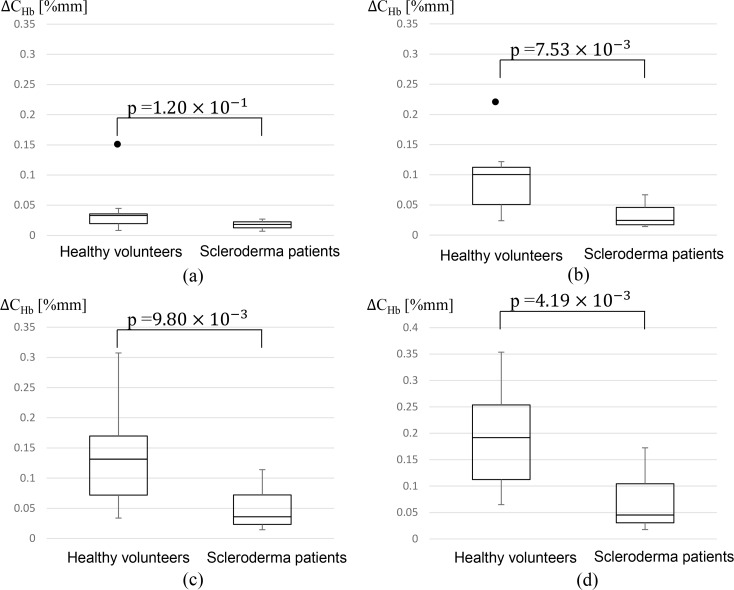
ΔCHb measured in healthy volunteers aged 65 to 75 years old (N = 10) and scleroderma patients aged 65 to 75 years old (N = 10).(a):P2 = 88mmHg, (b):P2 = 64mmHg, (c):P2 = 40mmHg, and (d):P2 = 28mmHg.